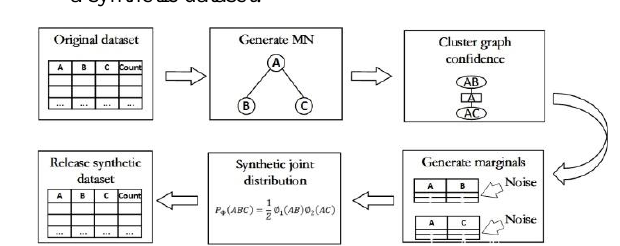
Fig.3. The detail steps of